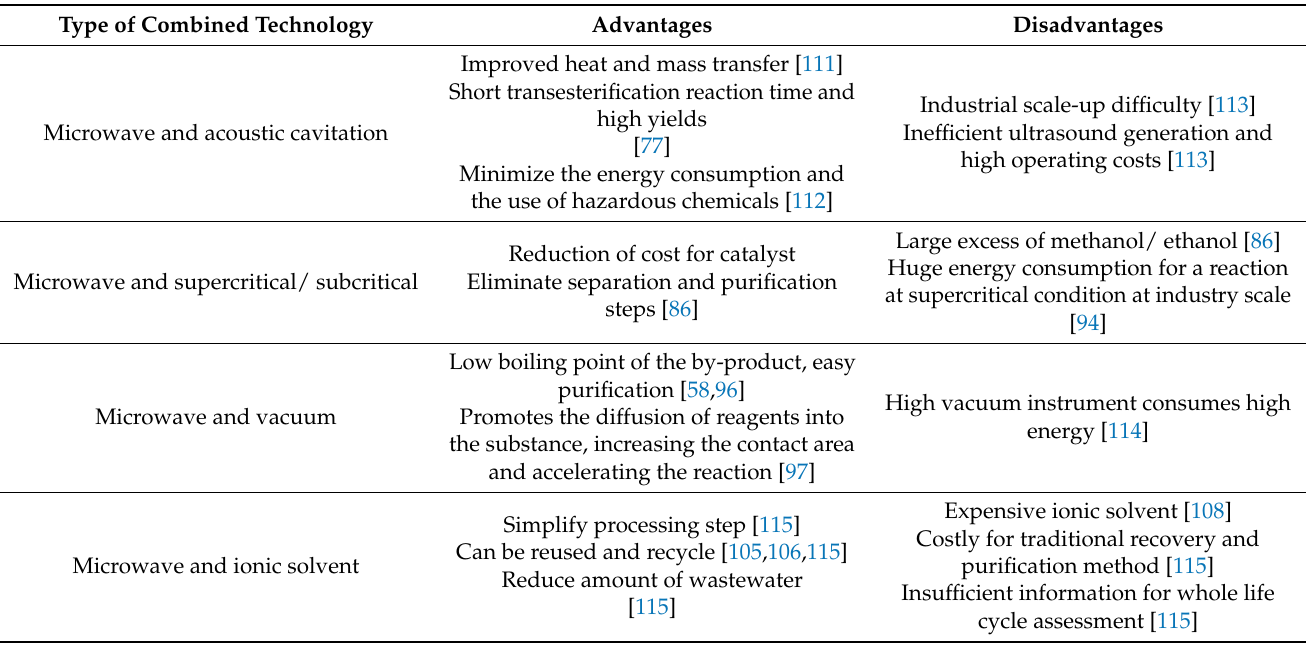
Table 7. Summary of microwave-combined